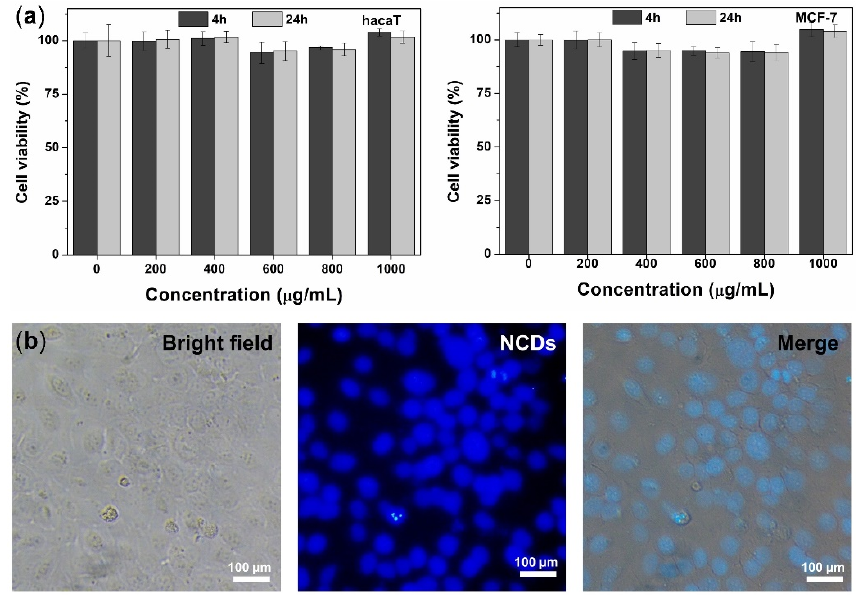
Figure 3. ( a ) Cytotoxicity of NCDs at different concentrations (0–1 mg/mL) toward HaCaT and MCF-7 cells. ( b ) Bright field and fluorescence microcopy images of NCDs treated on MCF-7 cells after incubation at 37 °C for 30 min.